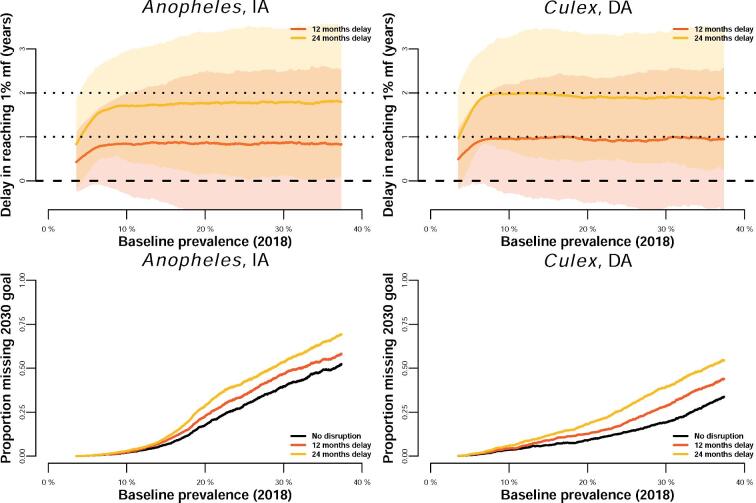
Moving average (window size of 4000) of the delay in reaching 1% mf prevalence (in years [top]) and the proportion missing the 2030 goals (bottom) for a wide range of baseline prevalences at the start of the current MDA programme in an Anopheles-transmitted setting treating with IA (left) and a Culex-transmitted setting treating with DA (right). The red and yellow lines illustrate scenarios with 12- or 24-month programme delays, respectively, after which annual MDA with 65% coverage continues. Shaded areas illustrate the standard deviation (volatility).